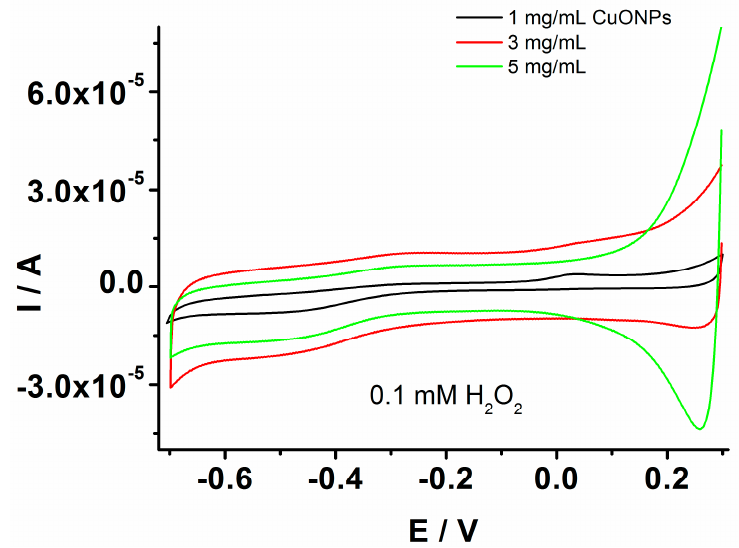
Figure 7. CVs recorded for the GCE modified with the composite material based on PE- DOT-CuONPs with different loadings of CuONPs on the PEDOT matrix, 1 mg/mL (black line), 3 mg/mL (red line), and 5 mg/mL (green line), in the presence of 0.1 mM H2O2; potential scan rate: 50